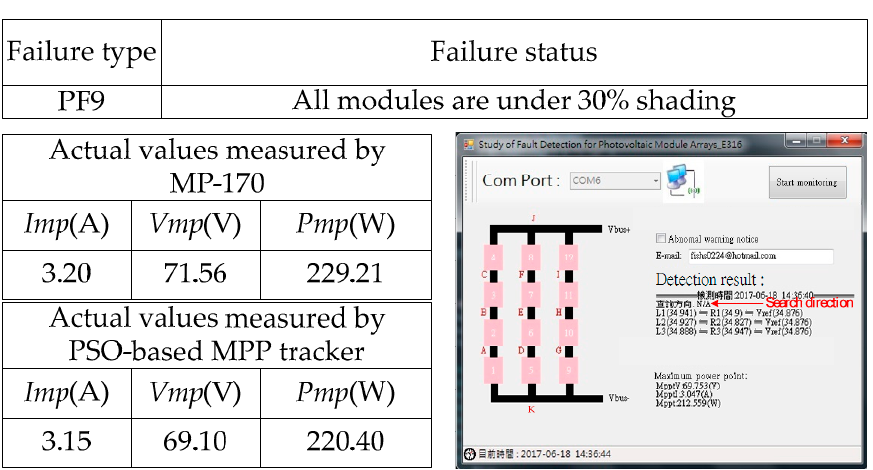
Table 2. Comparison of fault diagnosis accuracy rates when applied in a binary search-based method and the existing neural network methods. Comparison item Method Iteration number